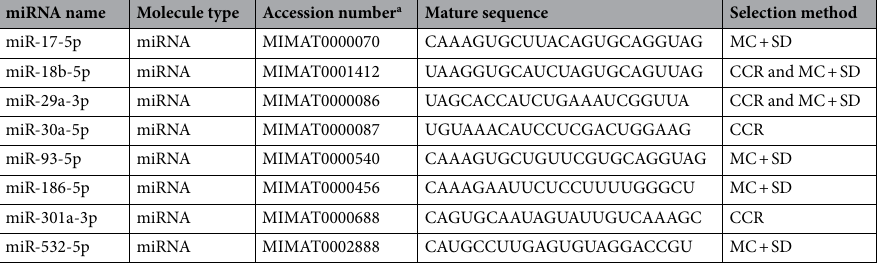
Table 2. Candidate endogenous controls. miRNA, microRNA; MC + SD, mean-centre + standard deviation; CCR, concordance correlation restricted. a mirBase database accession